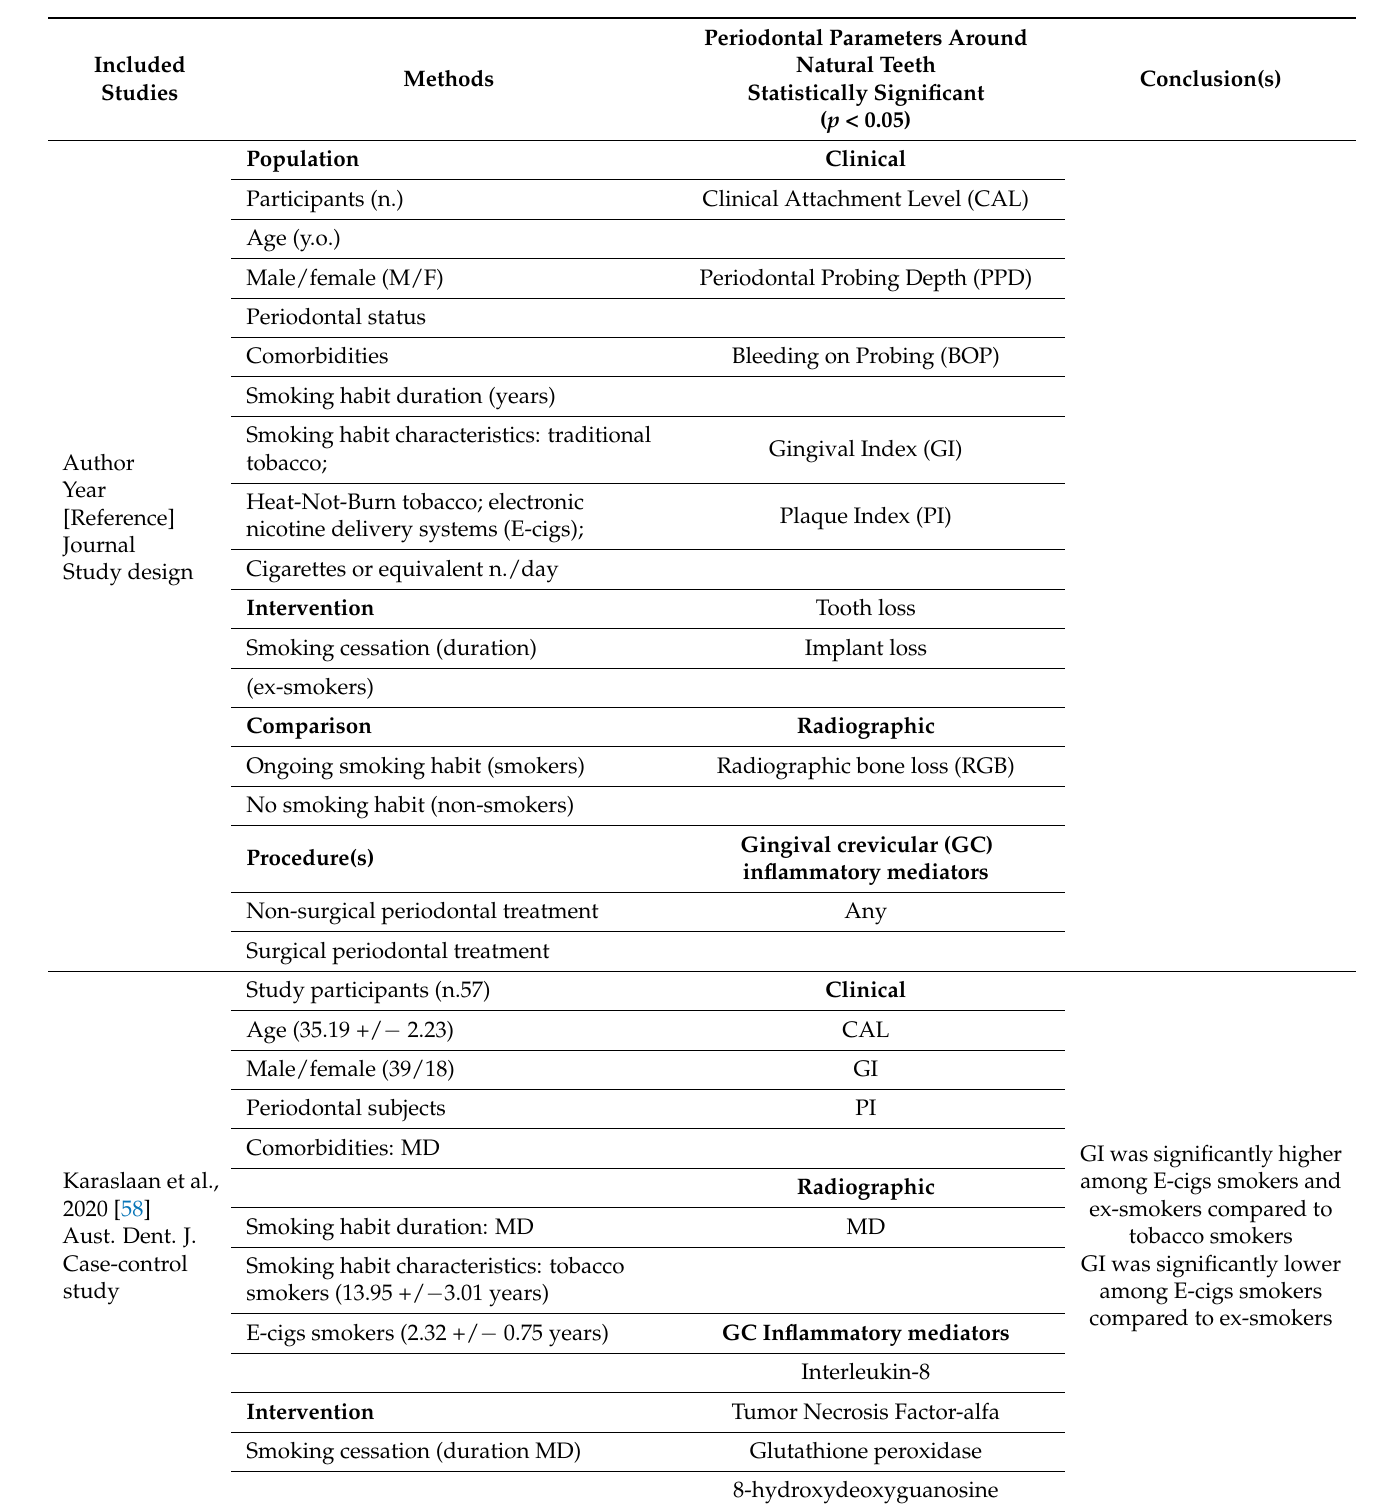
Table 2. Data extracted and collected from the studies included in the present systematic review: general information; methods; periodontal outcomes;